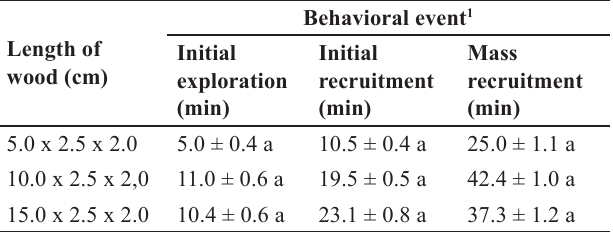
Table 1 . Elapsed time (average ± SD) from the beginning of the test to the occurrence of initial exploration, initial recruitment and mass recruitment exhibited by the workers of Nasutitermes c orniger (n = 20) on the wood of Eucalyptus grandis offered in three lengths in a situation of choice during 60 minutes of observation under laboratory